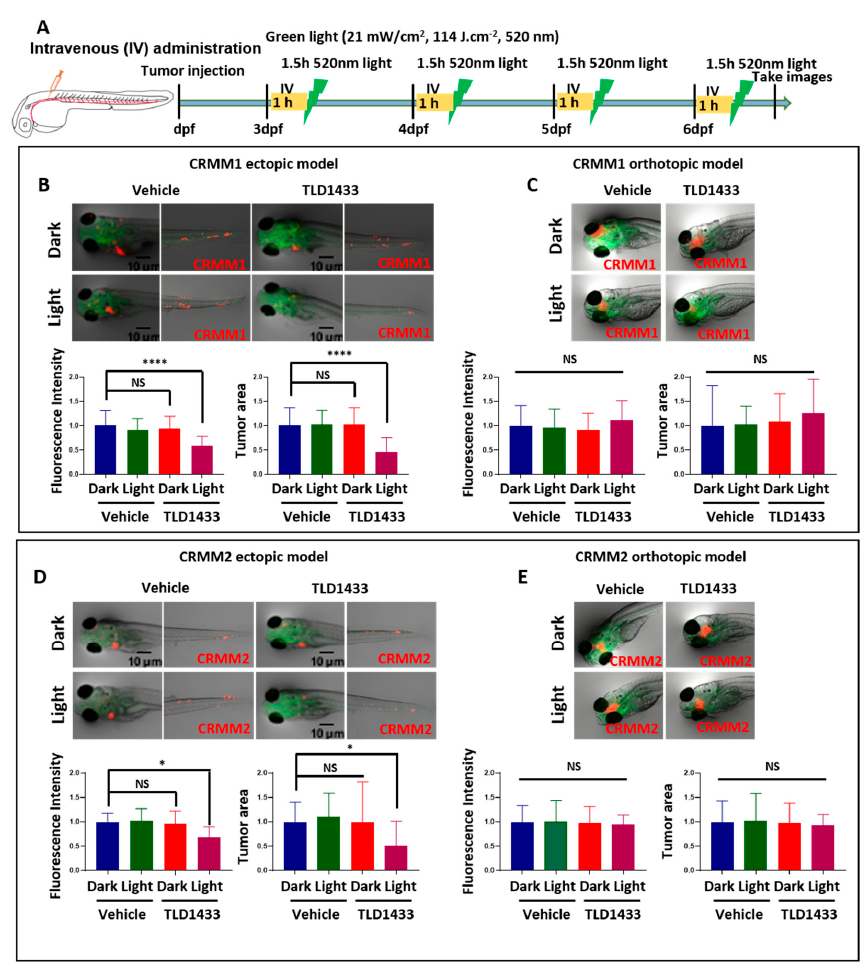
Figure 8. TLD1433 treatment by IV administration in the zebrafish ectopic and orthotopic CM model. ( A ) Schedule of tumour injection and TLD1433 administration in zebrafish embryos. Relative tumour burden was calculated as described in Figure 7. ( B ) CRMM1 tumour burden in the ectopic model ( n ≈ 30). ( C ) CRMM1 tumour burden in the orthotopic model ( n ≈ 15). ( D ) CRMM2 tumour burden in the ectopic model ( n ≈ 30). ( E ) CRMM2 tumour burden in the orthotopic model ( n ≈ 15). Results are presented as means ± SD from three independent experiments. Representative images show CM tumour burden in the head and tail regions in ectopic model and localised tumours in the orthotopic model. Table 4. The relative tumour burden quantified by tumour area in zebrafish embryonic models after treatment with TLD1433 delivered by three di ff erent administration routes. The tumour area is calculated as percentage, compared to the control dark group